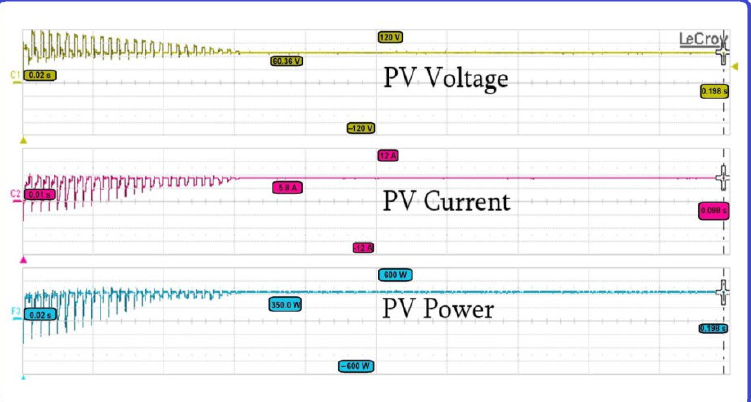
Figure 16. Experimental results of MPA technique for case 4.